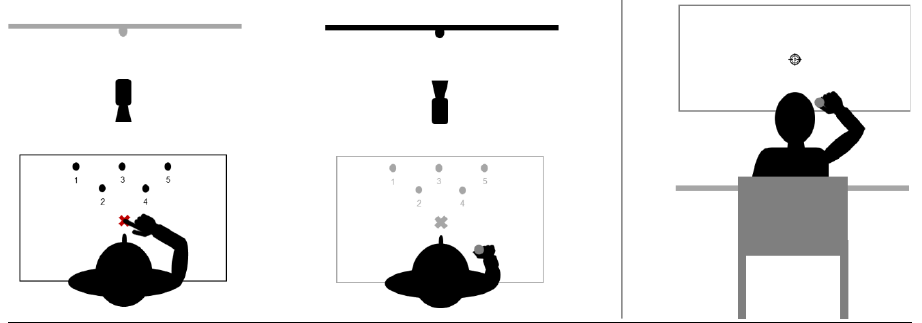
Figure 2. Tasks set-up. The left panel shows the top view of the pointing and throwing tasks, respectively. The right panel is a posterior view of the throwing